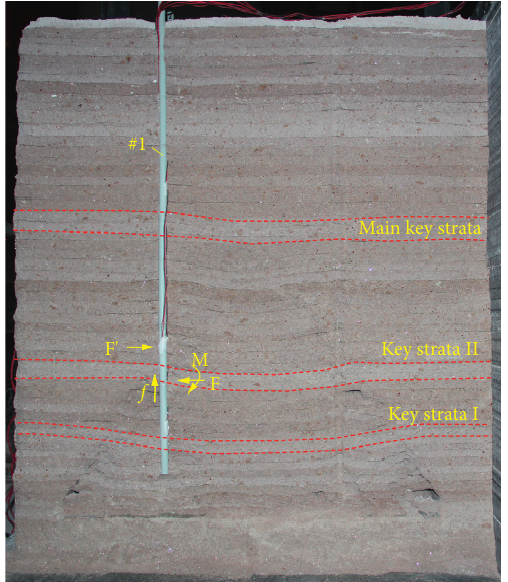
Figure 12: Observation of the deformation of surface well #1.